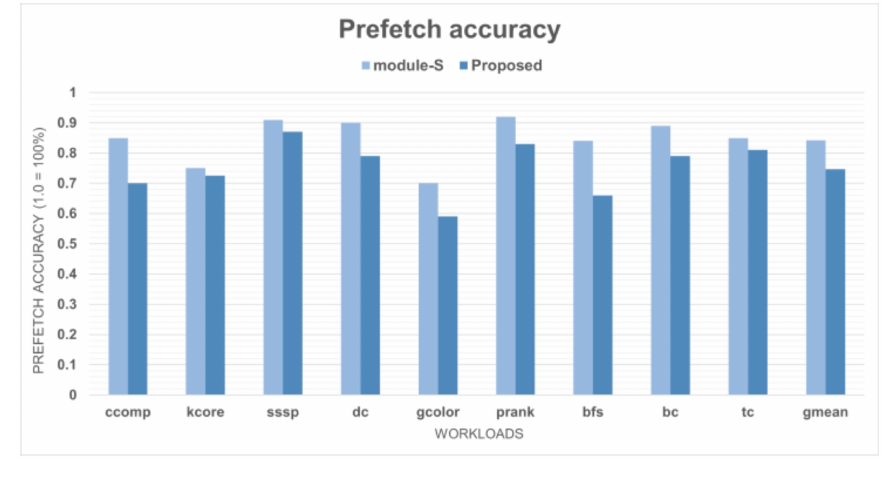
Figure 13. Prefetch accuracy for graph processing.